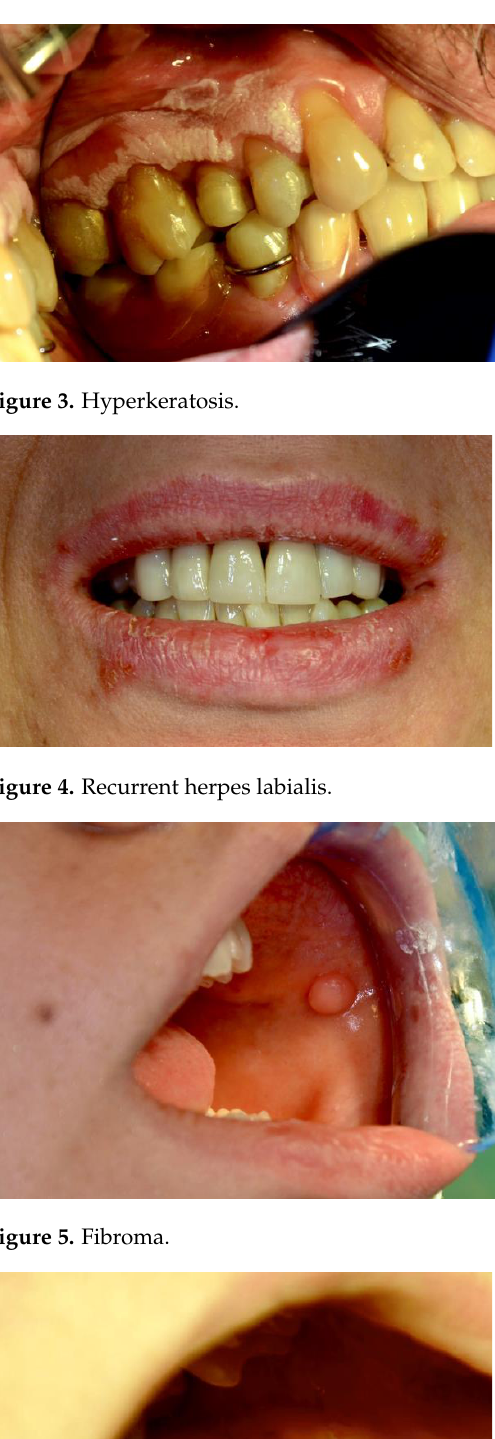
Figure 2. Oral atrophic mucositis.